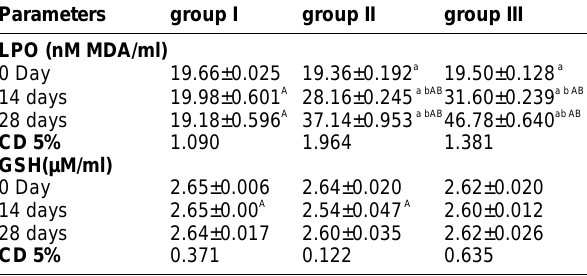
Table-4. Effect on serum enzymatic activities following daily oral administration of Jatropha seed oil with our without treatment for 28 days in goats (mean ± S.E., N=3 per group).